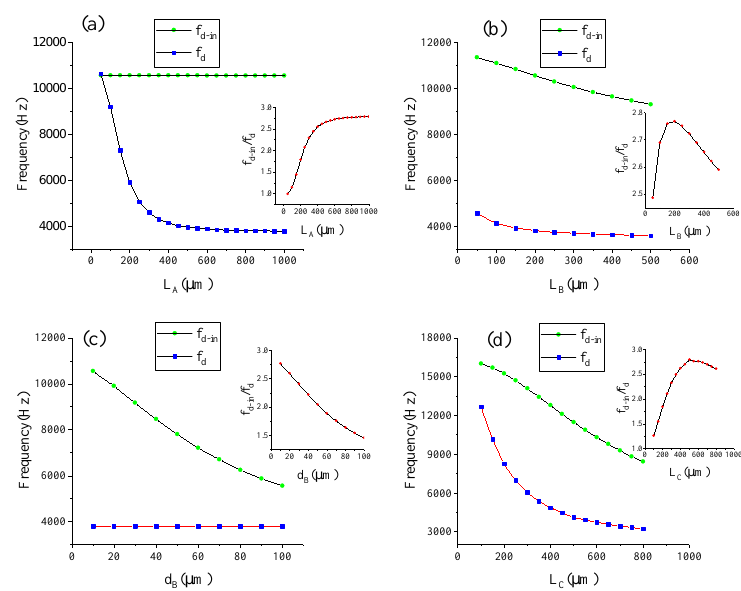
Figure 13. The relationships between f d − in , f d and f d − in / f d of Type-B and: L A ( a ); L B ( b ); d B ( c ); L C ( d ).